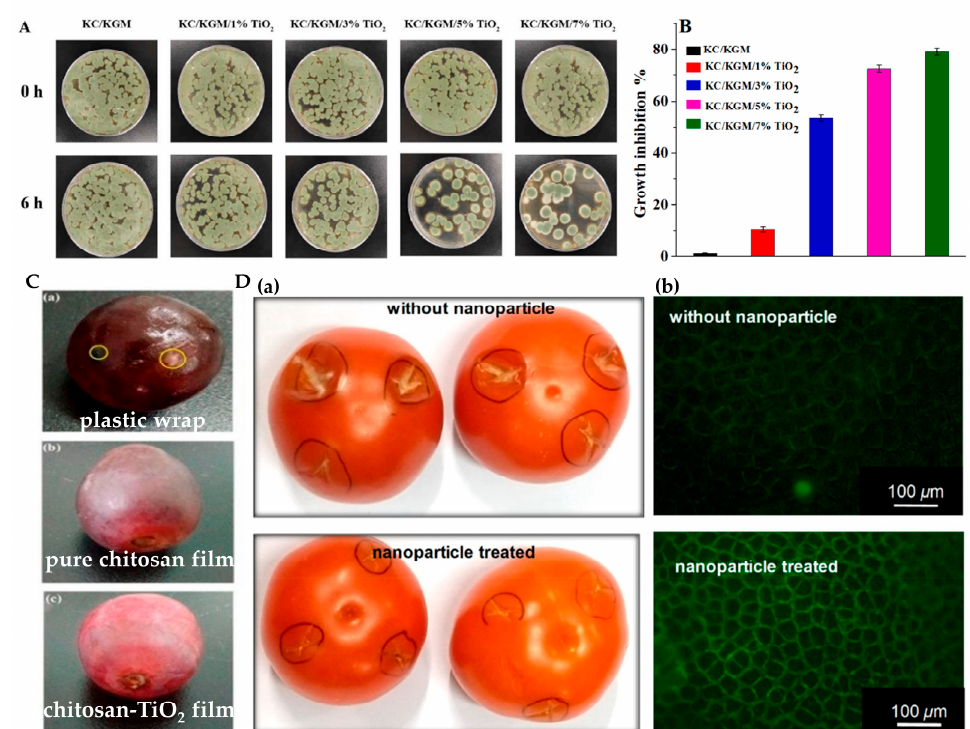
Figure 13. ( A ) Effect of the prepared composite films on the growth of P. viridicatum after 0 h and 6 h of irradiation; ( B ) effects of TiO 2 content on the inhibition efficiency of KC/KGM/TiO 2 nanocomposite films against P. viridicatum [138]; ( C ) preservation of red grapes packed in different materials at 37 ◦ C for 6 days [116]; ( D ) ( a ) in vivo fungitoxicity and infection control by nanoparticles. ( b ) Evidence of intact immunity of nanoparticle and visible-light-treated tomato fruit via nitric oxide imaging. Green fluorescence indicates the presence of nitric oxide [65].